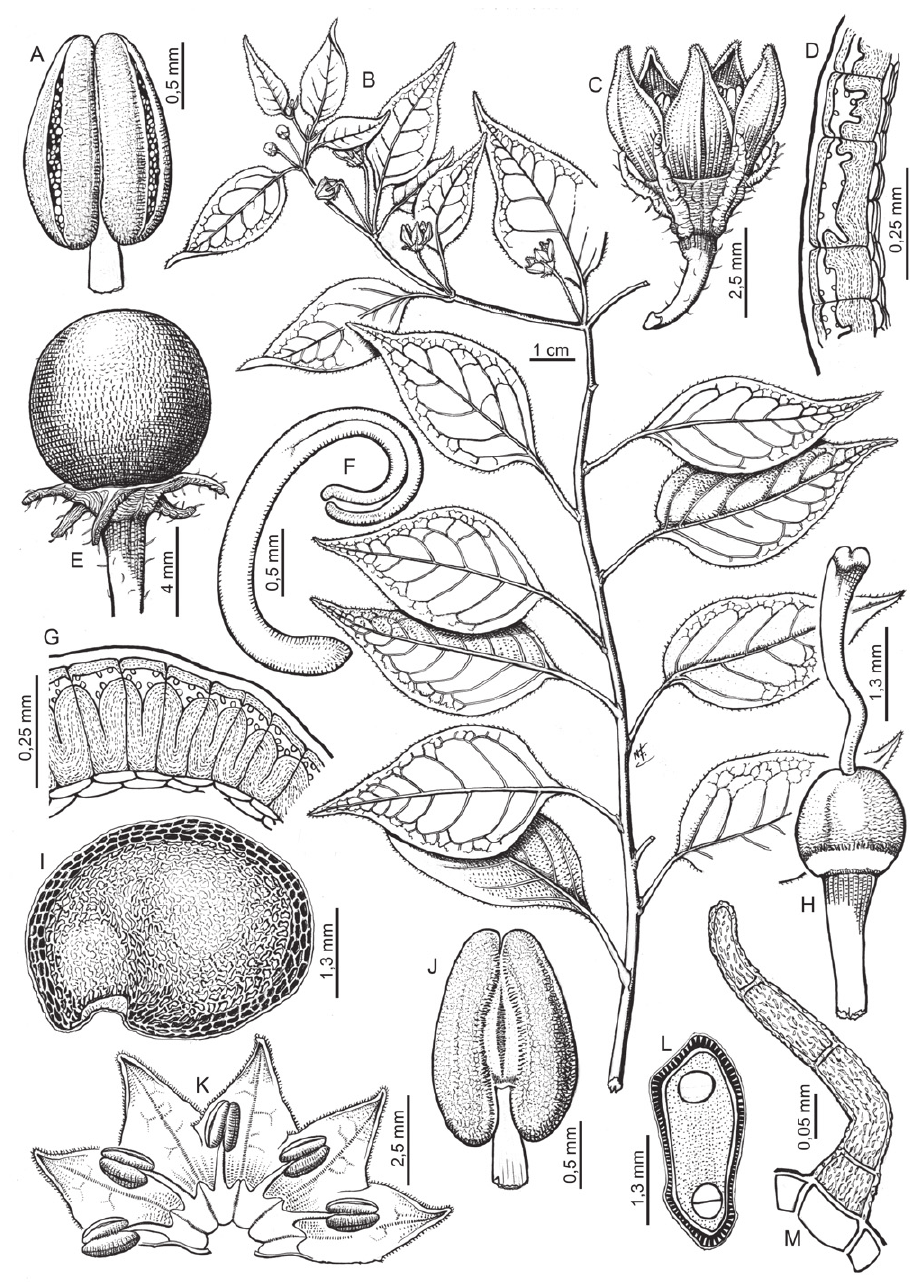
Figure 3. Capsicum eximium . A, J anthers in ventral and dorsal view respectively B fl owering branch C fl ower D, G transverse section of the seed coat E fruit F embryo H gynoecium I seed K open corolla L seed in cross section M non-glandular trichome. Line drawing by N. Flury; voucher A, C-M: Hunziker 1907; B, Hunziker